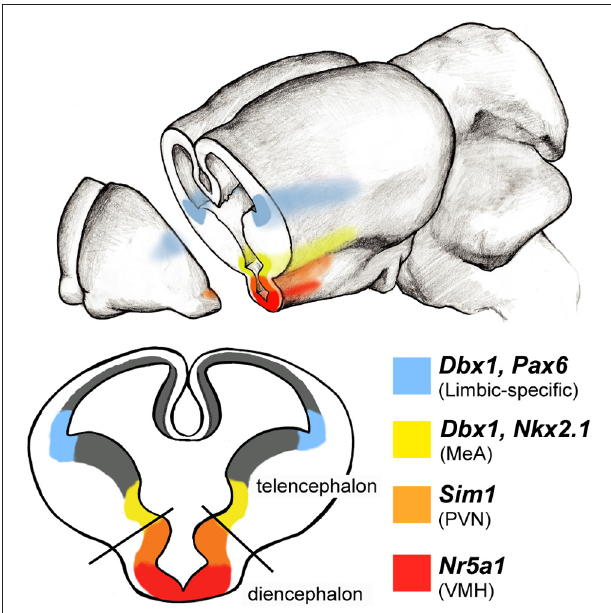
FIGURE 4 | Limbic system progenitor pools in the rodent embryonic brain. Schematic of a coronal view of an embryonic brain at midneurogenesis ( ∼ E14) reveals expression patterns of select transcription factors along the ventricular zones of the telencephalon and diencephalon. Combinatorial codes of transcription factor expression during embryogenesis determine the identity of neurons destined for various brain regions. A large portion of amygdala neuronal populations arise from two regions of the developing brain: the pallial-subpallial boundary (blue) and preoptic area (yellow) each of which express unique combinations of transcription factors. Areas of the hypothalamus also express regionally specific transcription factors: for example Sim1 (orange) is expressed more dorsally to specify cells in the paraventricular nucleus (PVN), while Nra51 (red) is expressed ventrally and specifies neurons in the ventral medial hypothalamus